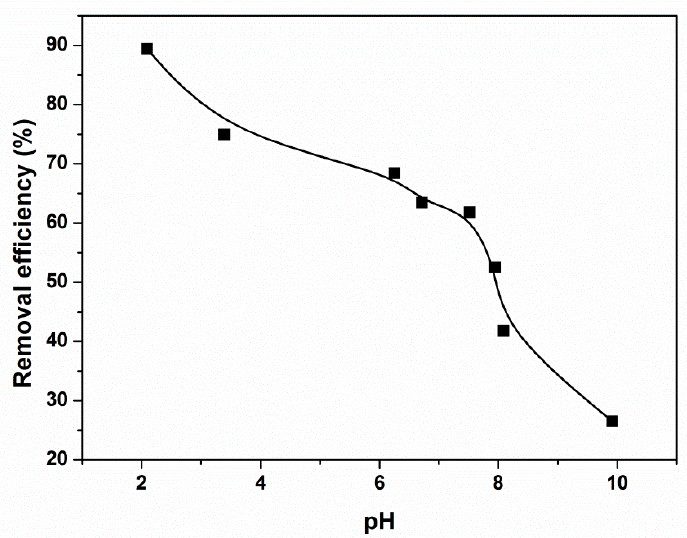
Figure 7. Effect of pH on the removal of CR by PGMA-g-PPy. (Adsorbent dose, 15 mg; volume, 6 mL; initial concentration, 500 mg/L; contact time, 1 h.)